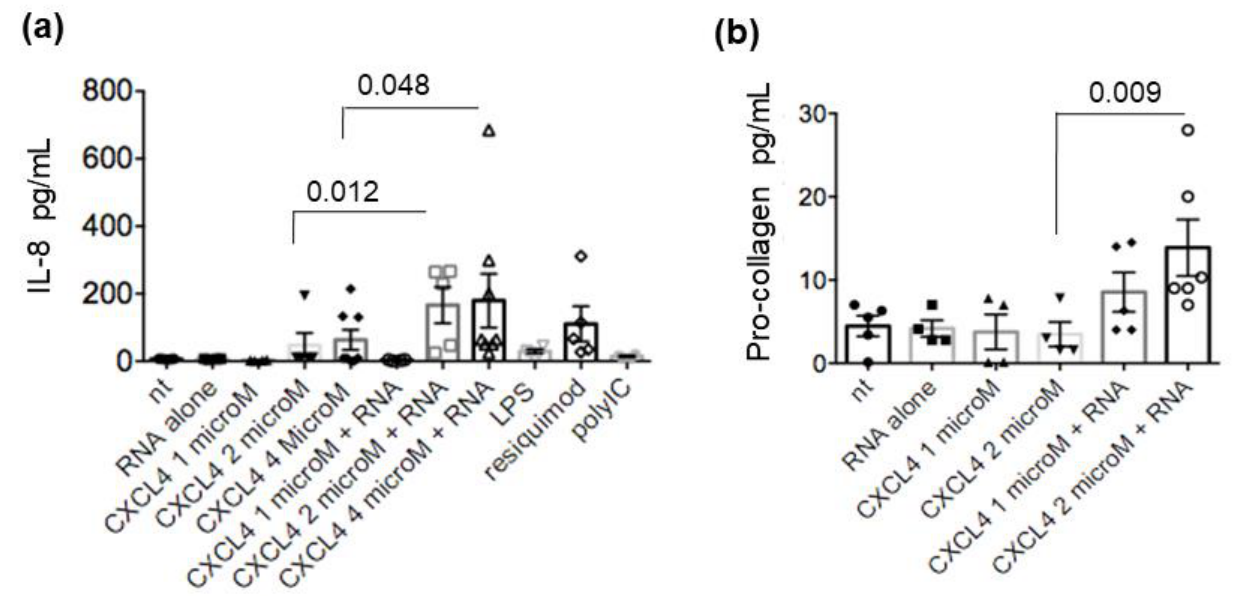
Figure 5. MDDCs are stimulated to produce pro-inflammatory/pro-fibrotic factors by CXCL4-RNA complexes. MDDCs were either untreated (nt) or treated with RNA alone or CXCL4 alone or with different amounts of CXCL4-RNA complexes or with TLR agonists. Production of the chemokine IL-8 ( a ) and pro-collagen ( b ) was evaluated by ELISA on culture supernatants harvested after 48 h. Results are from 3 to 8 experiments (depending on the stimulus) performed with MDDCs of different donors. p -values were by Mann–Whitney’s test.